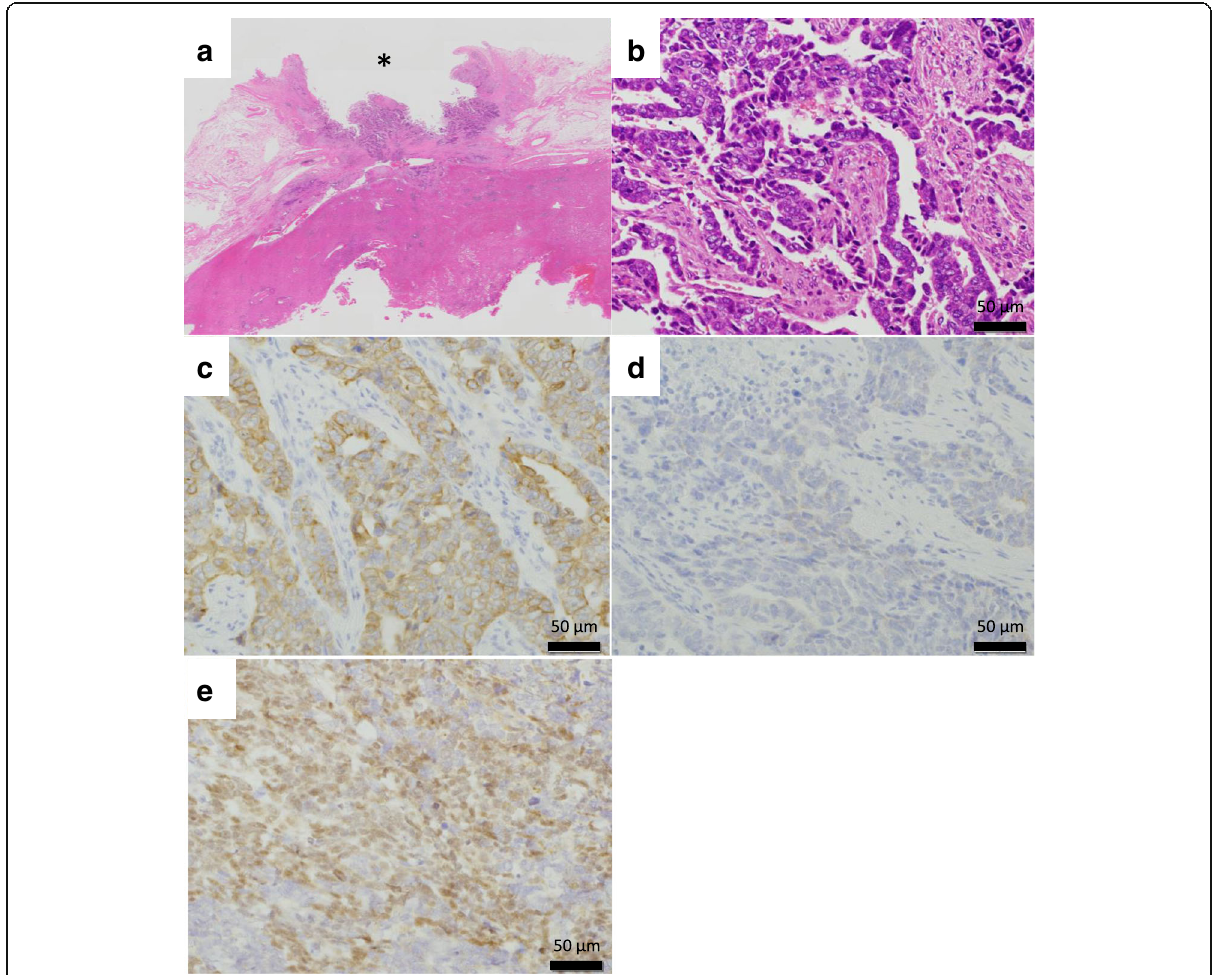
Fig. 6 Pathological findings. a Hematoxylin-eosin (HE) staining indicated tumor cells were localized in the bile duct and no infiltration into the hepatic parenchyma was observed. *: bile duct lumen. b Atypical proliferation of cells with enlarged nuclei and exhibiting irregular ductal structures. Immunohistochemical staining revealed that the tumor cells were positive for CK-7 ( c ) and WT-1 ( e ), and negative for CK-20 ( d